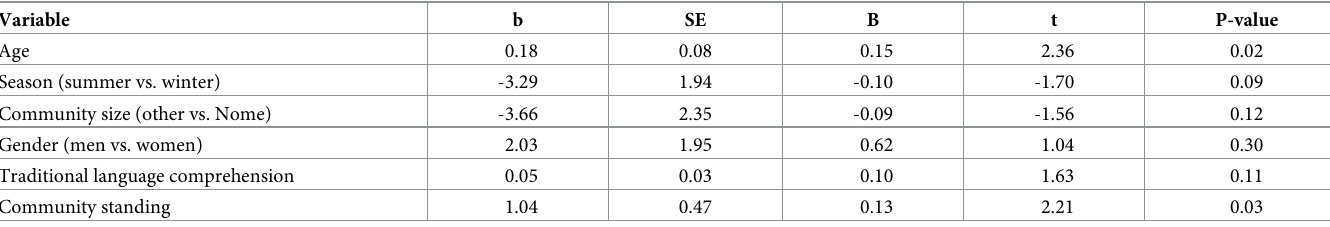
Table 4. Hierarchical multiple regression model predicting the traditional food index with community